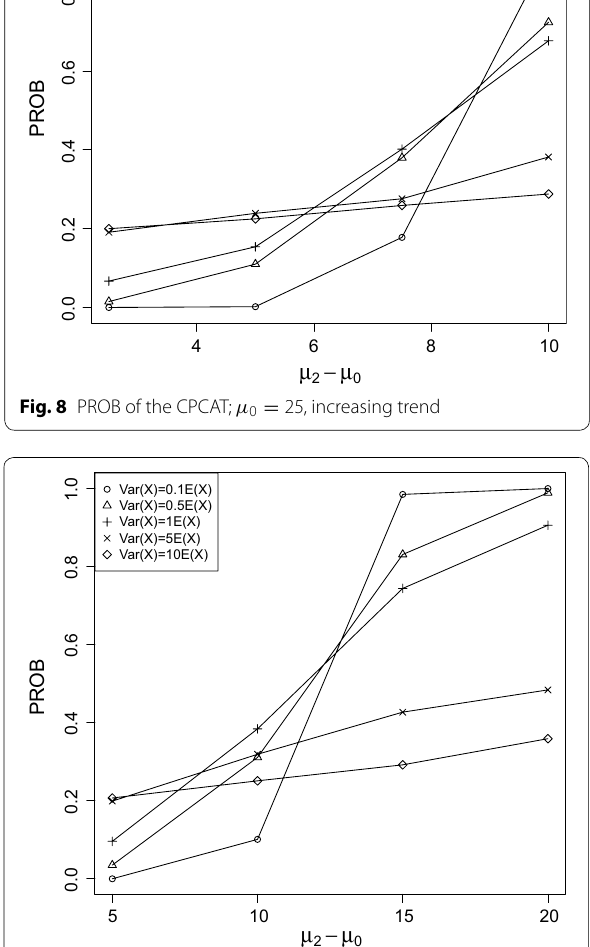
Fig. 9 PROB of the CPCAT; µ 0 = 50 , increasing